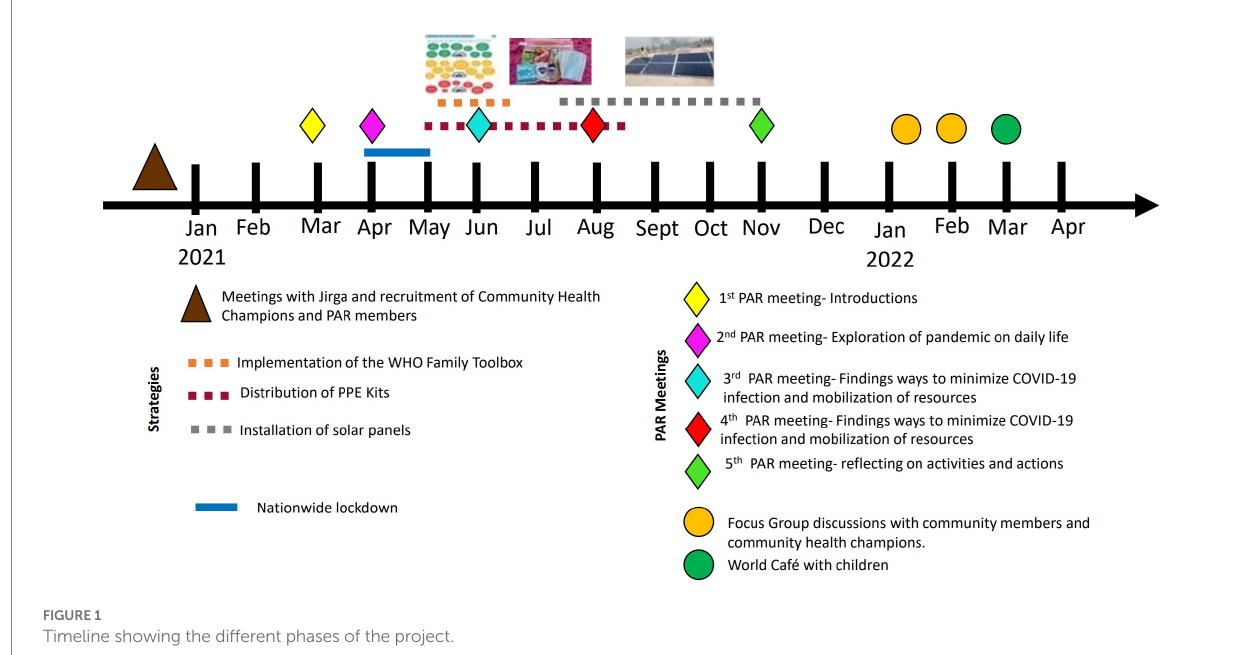
FIGURE 1 Timeline showing the different phases of the project.